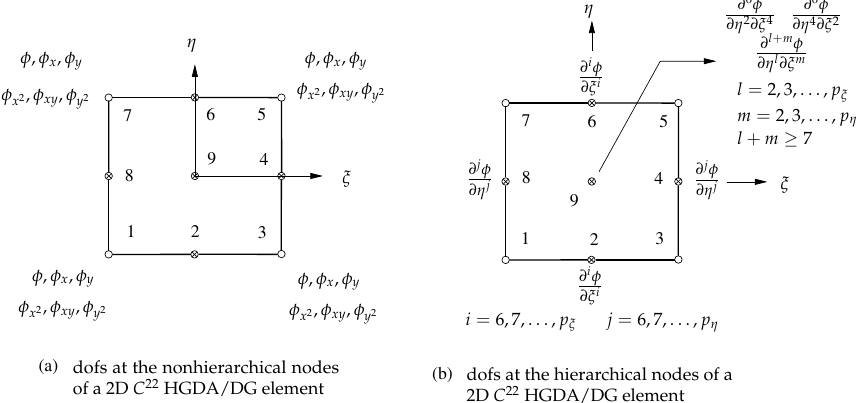
Figure 7. Nodal dofs for a 2D C 22 HGDA/DG quadrilateral